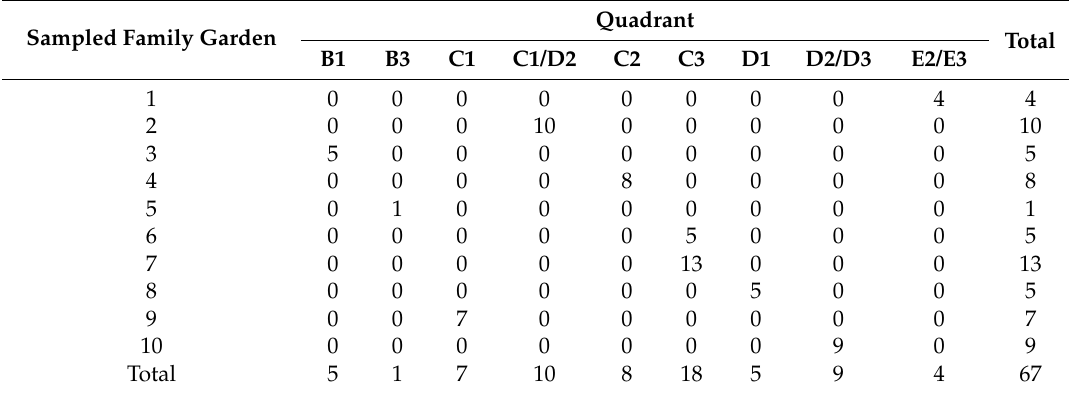
Table 2. Distribution of produce samples from Baroševac family